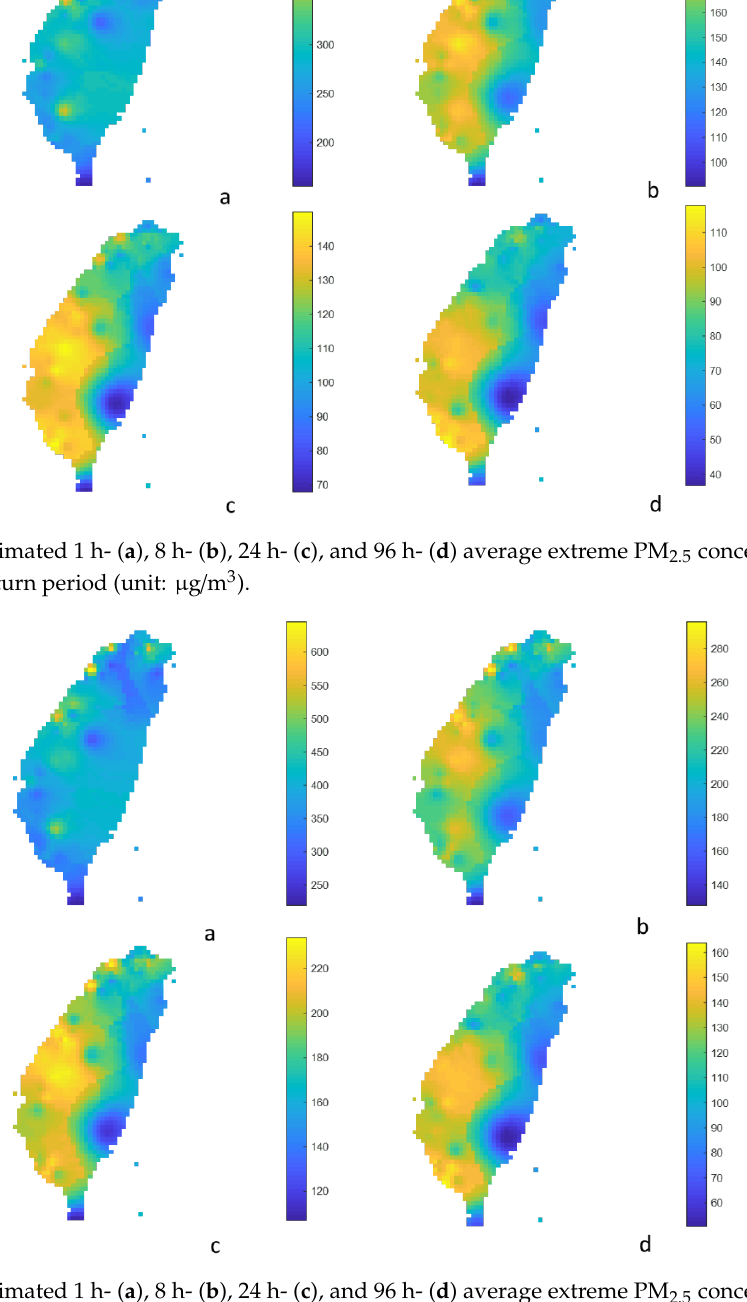
Figure 6. Estimated 1 h- ( a ), 8 h- ( b ), 24 h- ( c ), and 96 h- ( d ) average extreme PM 2.5 concentration for the 100-year return period (unit: μg/m 3 ).